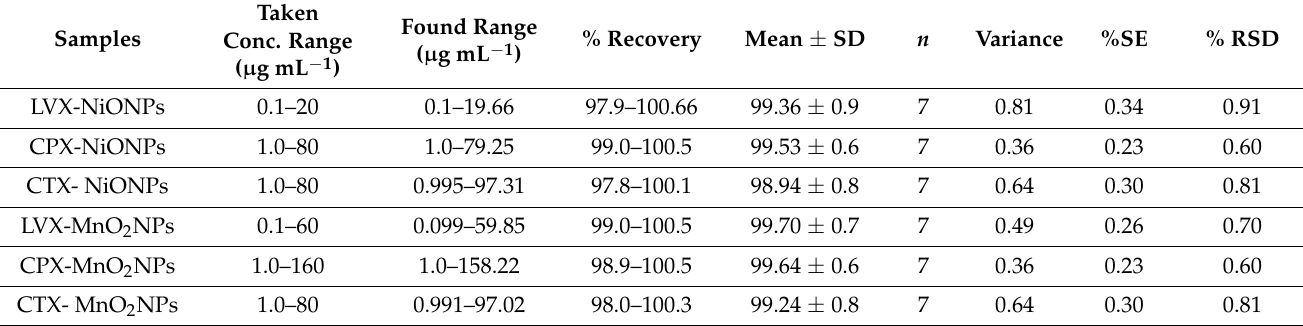
Table 5. Determination of LVX, CPX, and CTX in bulk powder using the proposed spectrophotometric method in the presence of NiONPs and MnO 2 NPs.